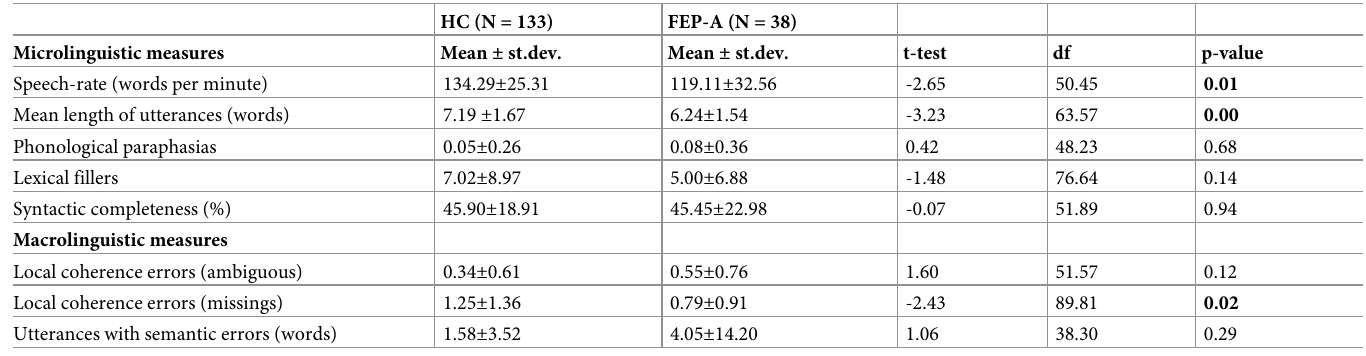
Table 4. Post-Hoc analysis (HC vs